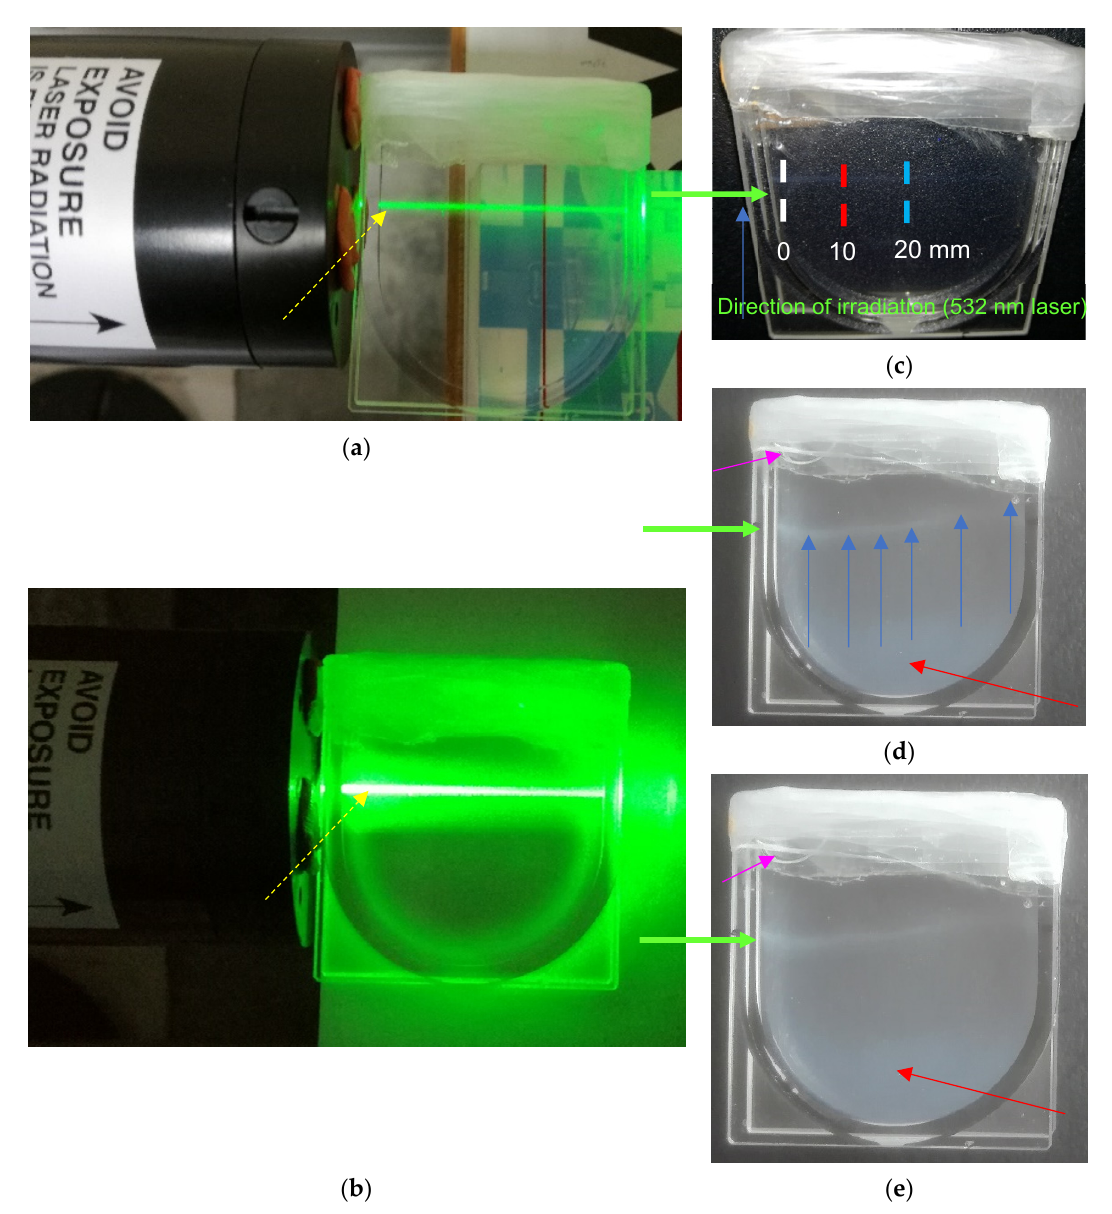
Figure 6. Visualization of the experiment reflecting irradiation of VIC-T in a flat quartz cuvette with green laser light of 532 nm (2 mW). The photograph in ( a ) corresponds to the irradiation at 0 min. In ( b ) is the same cuvette after 60 min irradiation. Yellow dash arrow is to point the region where polymerization and crosslinking took place during the irradiation. A thin line of the laser beam passing through the cuvette in ( a ) means no polymerization at the beginning of irradiation; however, a broader line of the laser beam in ( b ) denotes scattering of the laser light on large polymer molecules formed during irradiation. The photographs ( c – e ) illustrate the cuvette with VIC-T after irradiation: ( c ) immediately after 60 min irradiation, ( d ) 139 h after irradiation and ( e ) 215 h after irradiation. In ( c ) VIC-T in the cuvette is transparent and only a very thin white line can be spotted that corresponds to a polymerization and crosslinking effect; the line goes straight through VIC-T. In ( d ) this line bends upwards at a distance of around 10 mm (indicated by the blue arrows) and also the whole VIC-T volume converts to opaque (indicated in red arrow); in ( e ) self-polymerization is in progress, bending of the line is more profound. The opaqueness corresponds to a post effect occurred in VIC-T that was induced by the laser light highly scattered on the large molecules on the laser light line passing though the sample. In ( c ) the white, red and blue dash lines perpendicular to beam passing through the sample indicate the regions in which Raman spectroscopy was performed. Lilac arrow in ( d ) and ( e ) indicates a gel dosimeter concaved as a result of e.g., a bubble appeared over time after preparation or/and shrinking of polymer macromolecules formed in the whole dosimeter